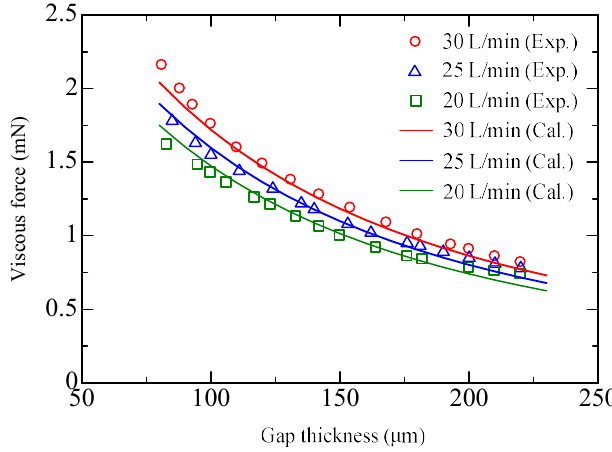
Figure 7. Viscous force versus gap thickness.